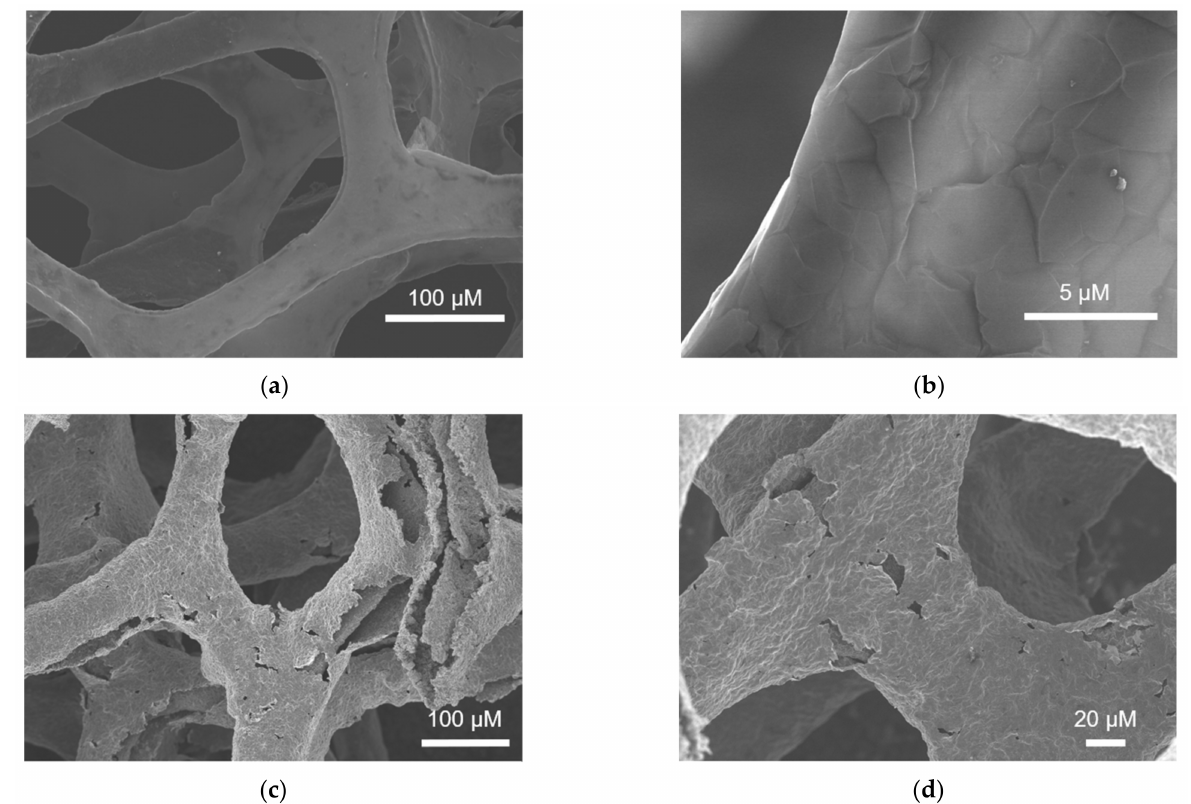
Figure 2. SEM images of 3DG ( a , b ) and p-3DG ( c , d ) at different